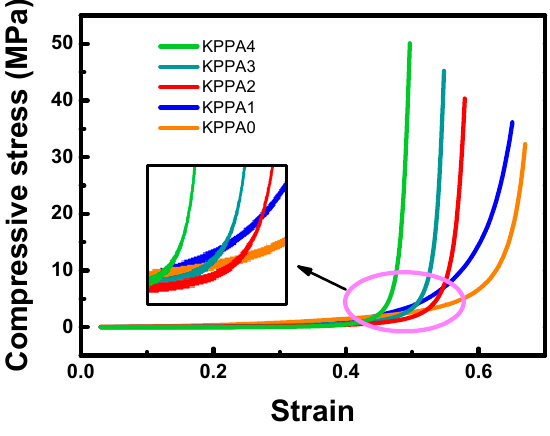
Figure 8. Compressive stress of the KPPA0, KPPA1, KPPA2, KPPA3 and KPPA4 cryogels.